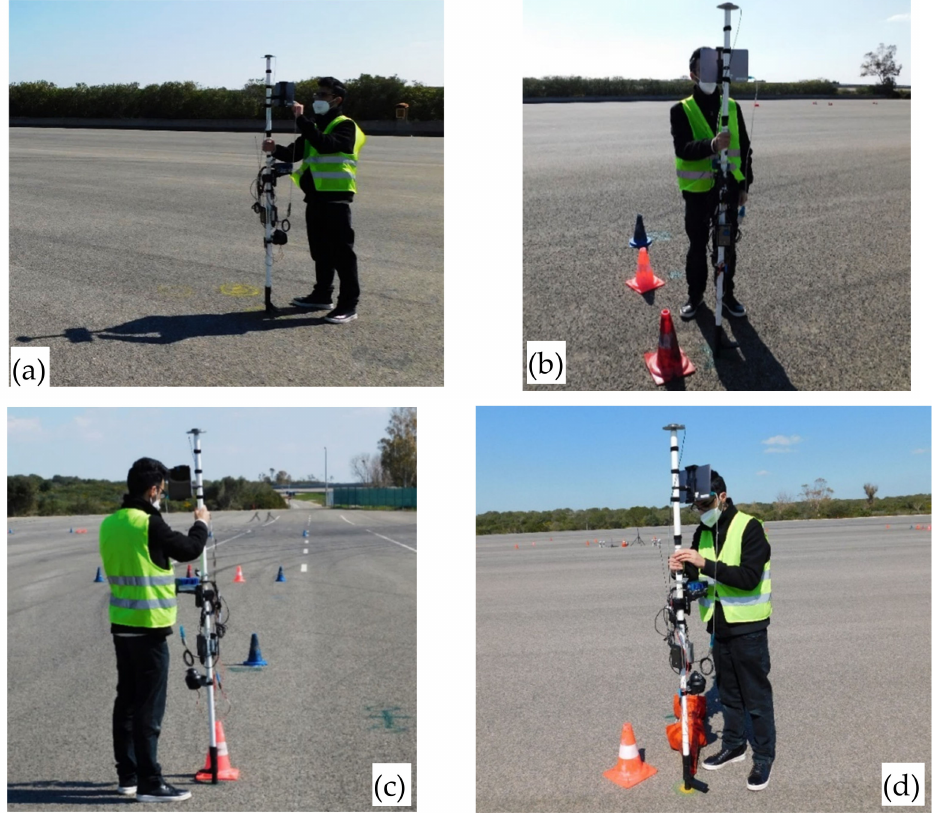
Figure 9. Use of the stake-out geolocation device to locate points with centimeter accuracy on a wide track ( a – c ) and record geographical coordinates of a point already marked on the ground ( d